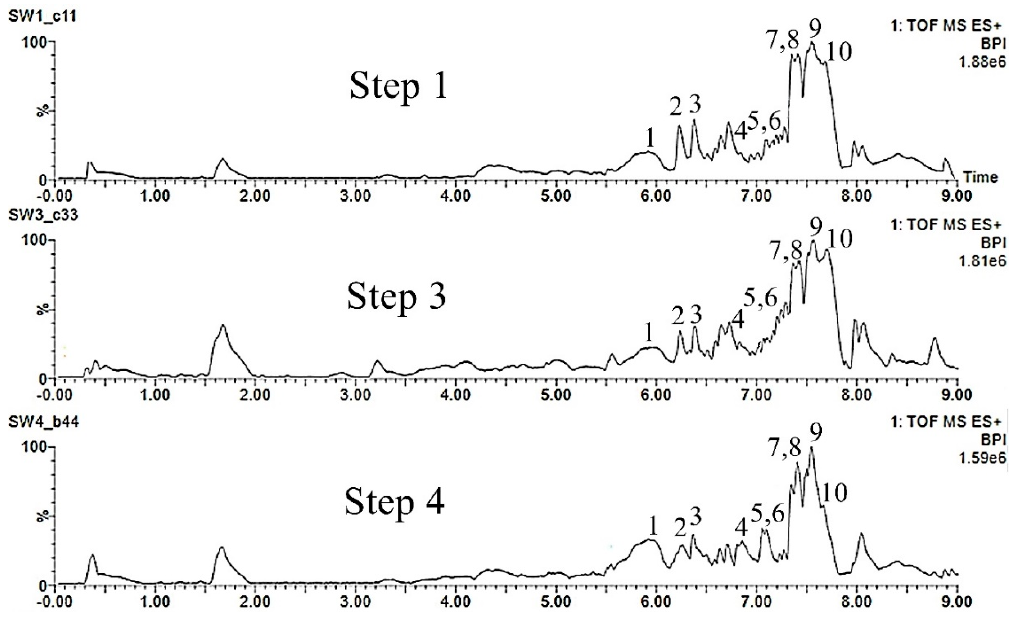
Figure 6. Base peak ion chromatograms comparing steps 1 to 4 of the leaf explants from Swietenia macrophylla.